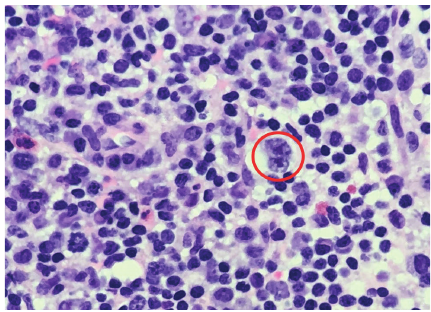
Figure 2: Bone marrow core showed foci of fibrosis with CD30- positive cells.